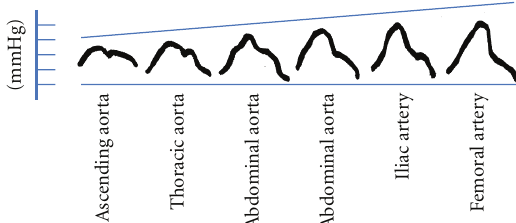
Figure 1: Changes in arterial pressure wave contour between ascending aorta and femoral artery (adapted from reference [4]).